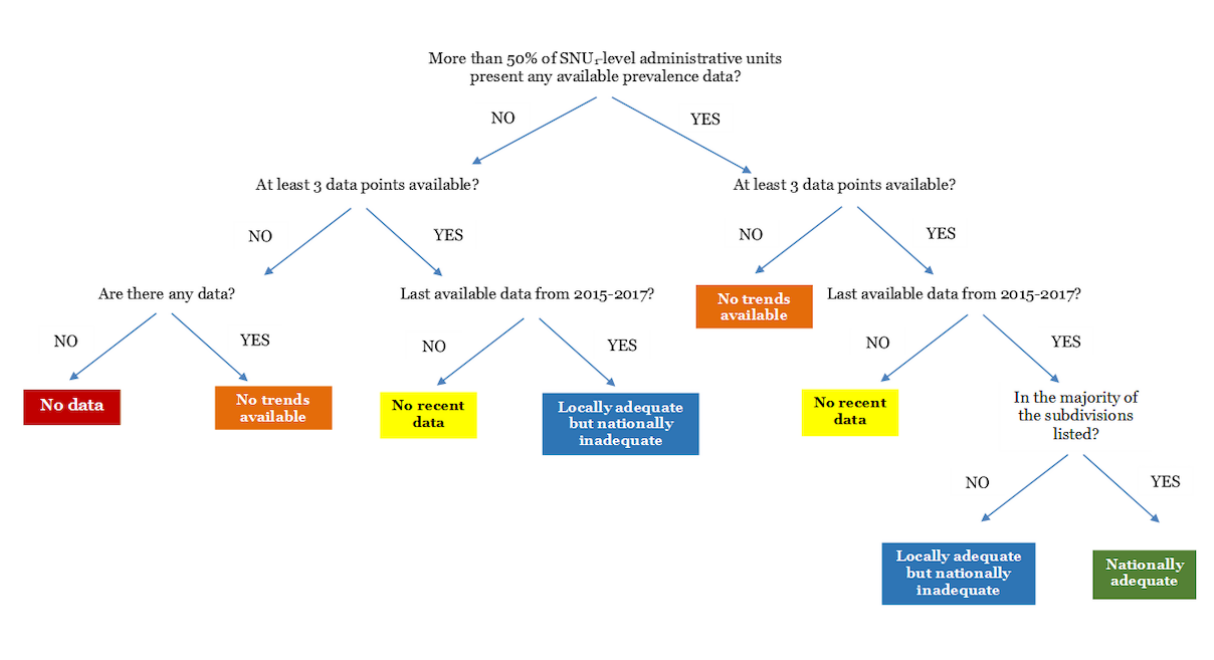
Figure 1. Decision tree depicting categorization of the subnational HIV prevalence data by key population and country. SNU 1 : first-order subnational administrative unit, such as a province, state, or